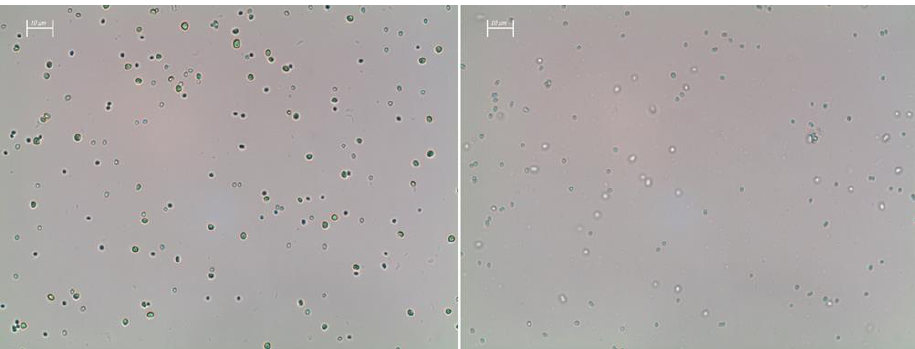
Figure A1. Mixed culture of Muriella sp. and Synechocystis sp. cultivated 5 days in BG-I medium. ( left ): without cycloheximide, ( right ): medium with 100 mg cycloheximide per liter. Scale bar: 10 µm.